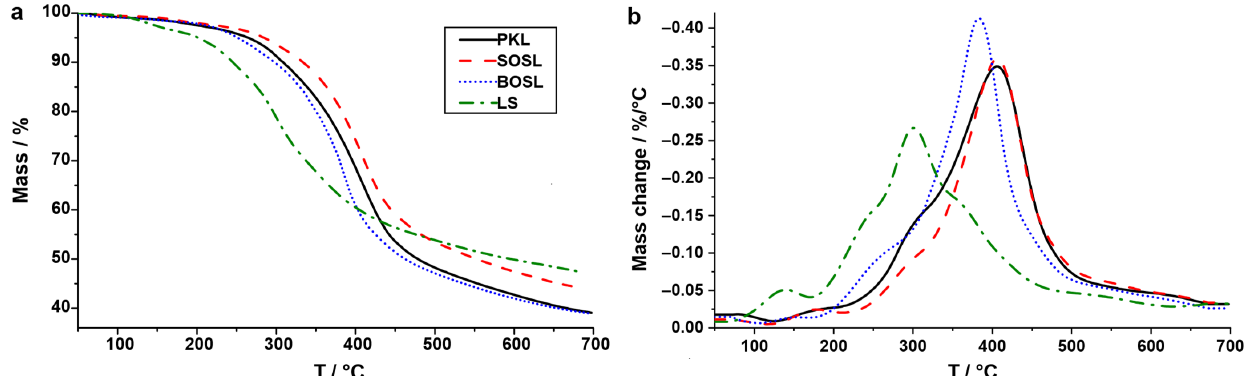
Figure 3. Mass ( a ) and mass change ( b ) as a function of the temperature of the four technical lignins: LS (green; dashes–dots); BOSL (blue; dot); SOSL (red; dash); PKL (black; solid line).